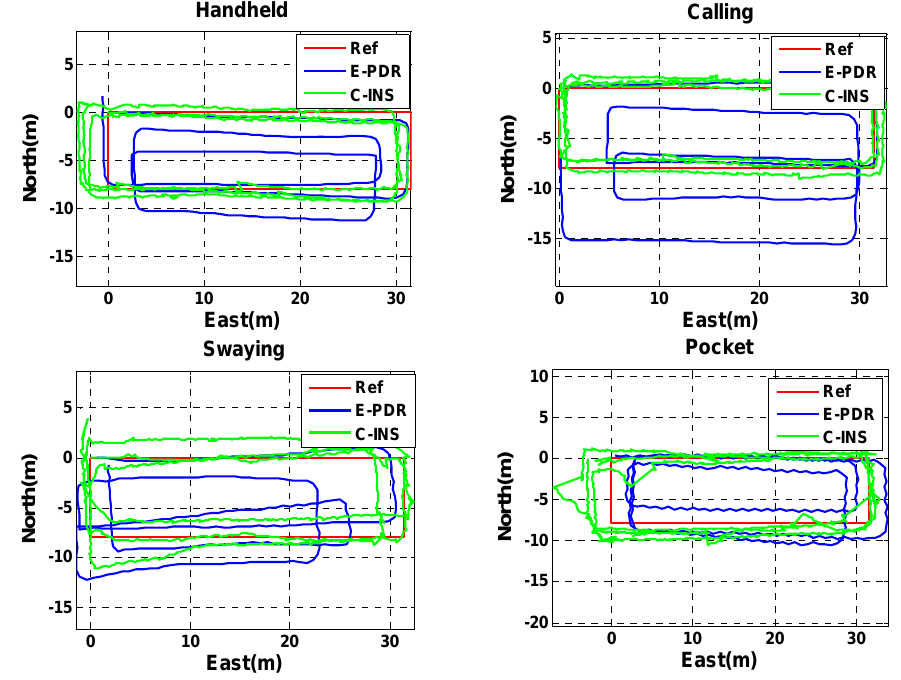
Figure 10. Trajectories of reference, E-PDR, and C-INS solutions with missing steps event for four different phone-holding positions. Sensors 2018 , 18 , x FOR PEER REVIEW